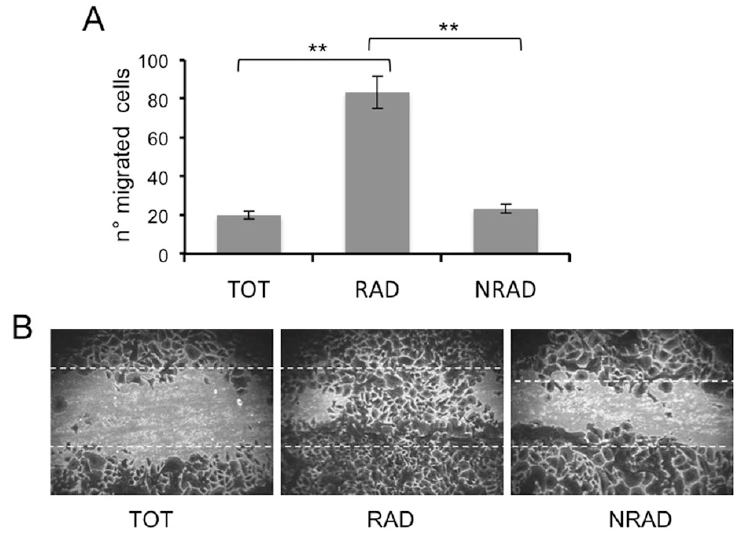
Figure 5. Migration ability of cSCCs subpopulations. The migration of RAD, NRAD and TOT cells was determined by scratching assay. Cells were fixed and stained, and the number of migrated cells to the scratched surface area was counted. ( A ) Number of migrated cells expressed as the mean + SD from triplicate experiments, * p < 0.05, ** p < 0.01; ( B ) Representative images of migrated cSCCs subpopulations in the scratching